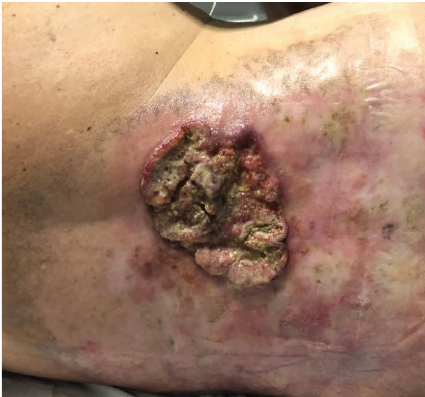
Figure 1: Exophytic ulcer 7-months after a thermic burn in the dorsal region. First patient visit to emergency department.